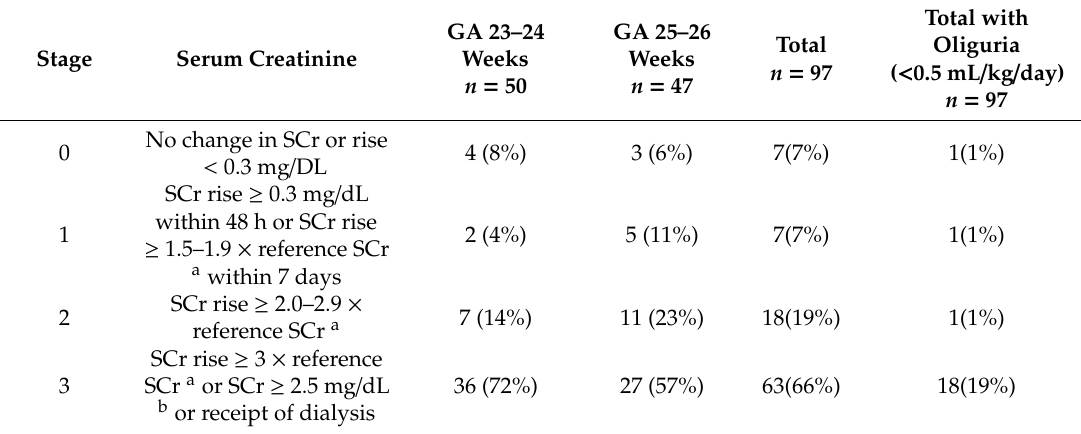
Table 1. The maximum AKI stage within a first month after birth according to neonatal acute kidney injury KDIGO